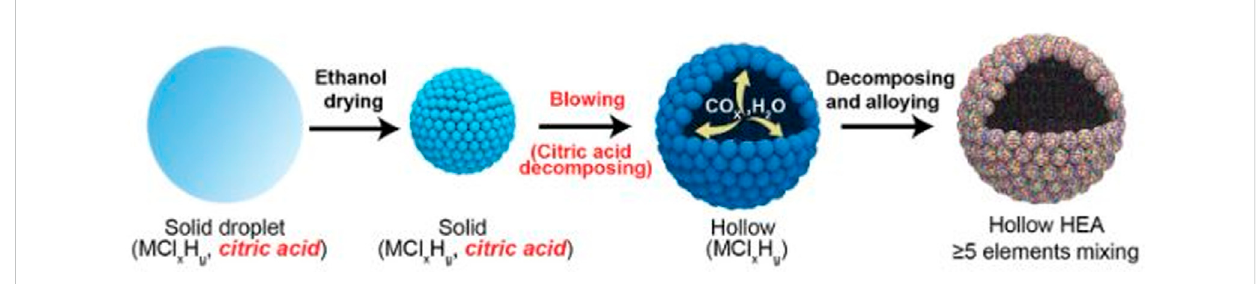
FIGURE 4 Schematic Diagram of droplet-to-particle evolution method of fabricating hollow high entropy alloy nanoparticles (Wang et al.,